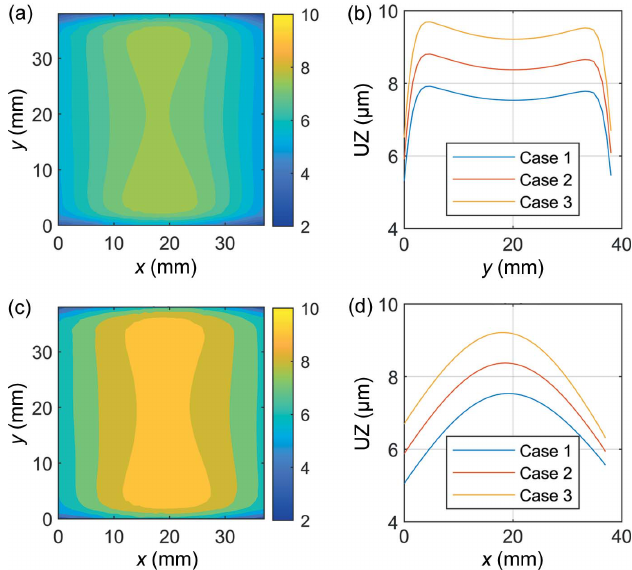
Figure 4 Distortion of the optical surface with ( a ) and ( c ) showing contour plots of maximum total deformation (nm) on the optical surface of the crystal for Case 1 and Case 3, respectively; and ( b ) and ( d ) showing vertical displacement UZ across the centre line of the optical surface of the crystal in the sagittal and meridional directions,